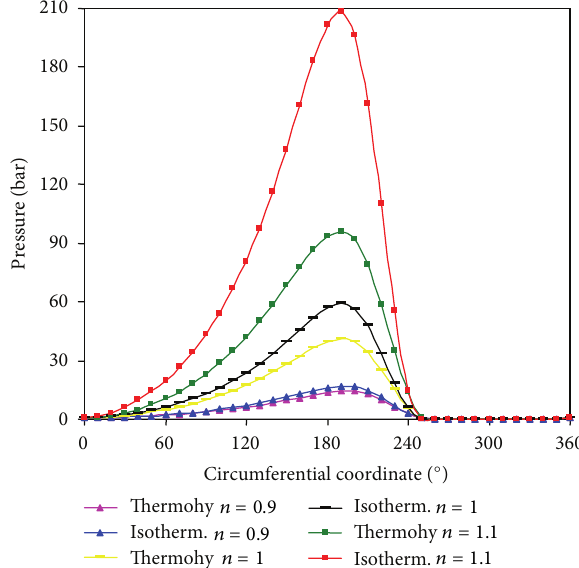
Figure 3: Pressure distributions versus the circumferential coordi- nate at the central plan of the journal bearing for different values of 𝑛 index. Comparison between isothermal and thermohydrodynamic cases.